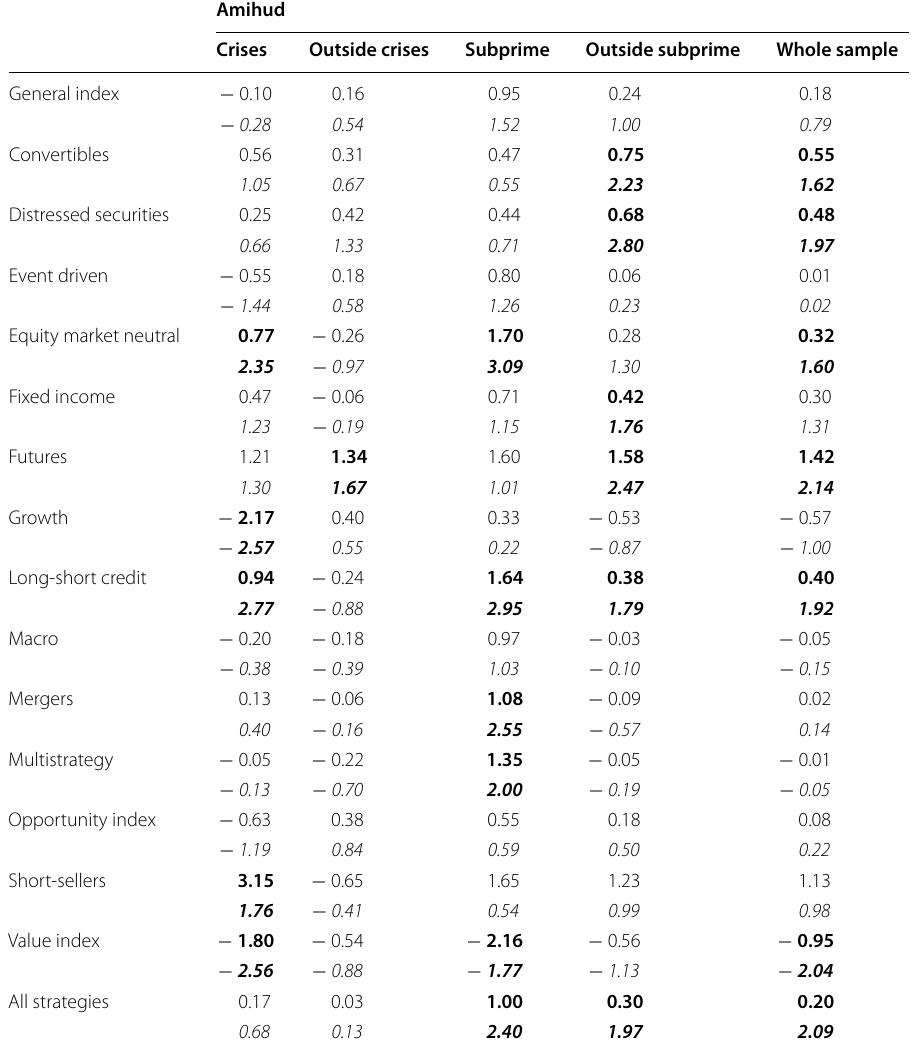
Table 6 Sensitivities of hedge fund strategies’ returns to the Amihud ratio using pooled regressions with fixed coefficients and SUR,